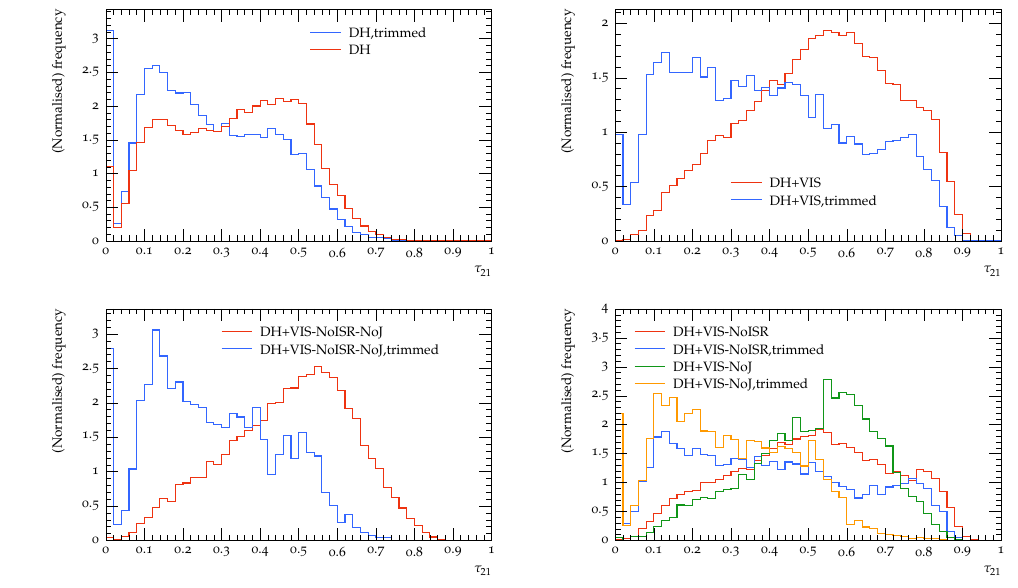
Figure 12: Comparisons of τ (right) between ungroomed and trimmed case, for 21 signal configurations corresponding to clustering only with dark hadrons (top left), dark and visible hadrons (top right) turning extra ME jets and ISR off (bottom left) and turning one (but not both) of them off (bottom right). The entries at zero cor- respond to cases where the substructure variable could not be